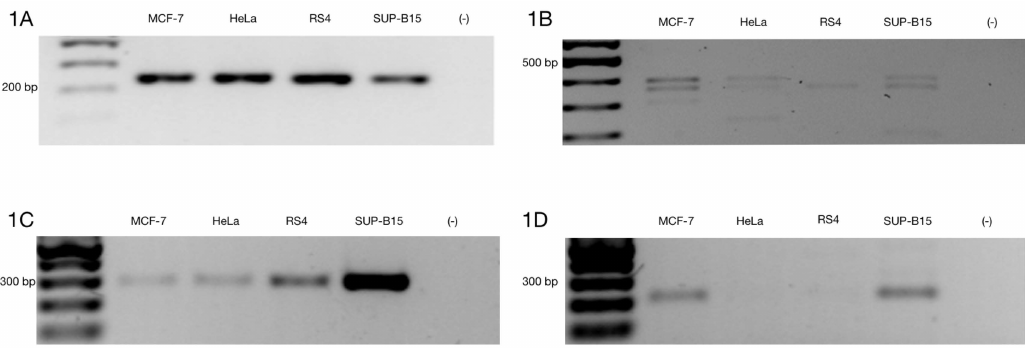
Figure 1. Alternative ZNF695 transcript variants are expressed in cancer cell lines. Gene expression was evaluated in MCF-7, HeLa, RS4, and SUP-B15 cell lines. ( A ) We observed homogenous expression of the RPL4 housekeeping gene in the four cell lines. ( B ) ZNF695 expression, including all transcript variants that were previously reported [46]. All cell lines expressed at least one of the ZNF695 transcripts, RS4 only expressed the ZNF695 variant TV1 and / or TV3 of ~400 bp, while the HeLa and SUP-B15 cell lines expressed two variants of ZNF695, which corresponded the expected lengths of 400 bp (TV1 / TV3)